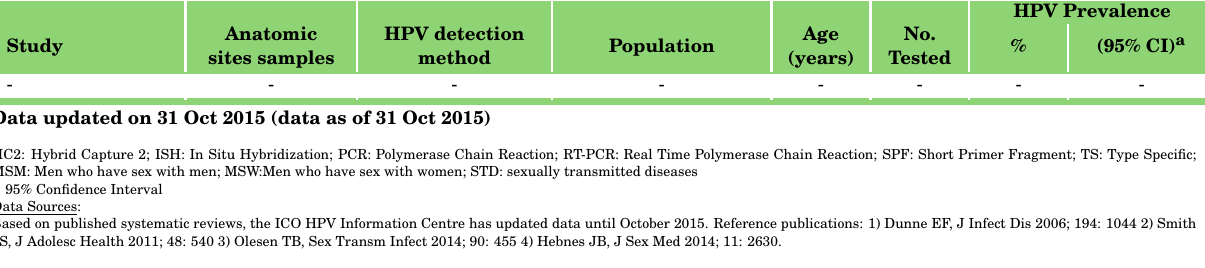
Table 33: Studies on HPV prevalence among men in Peru